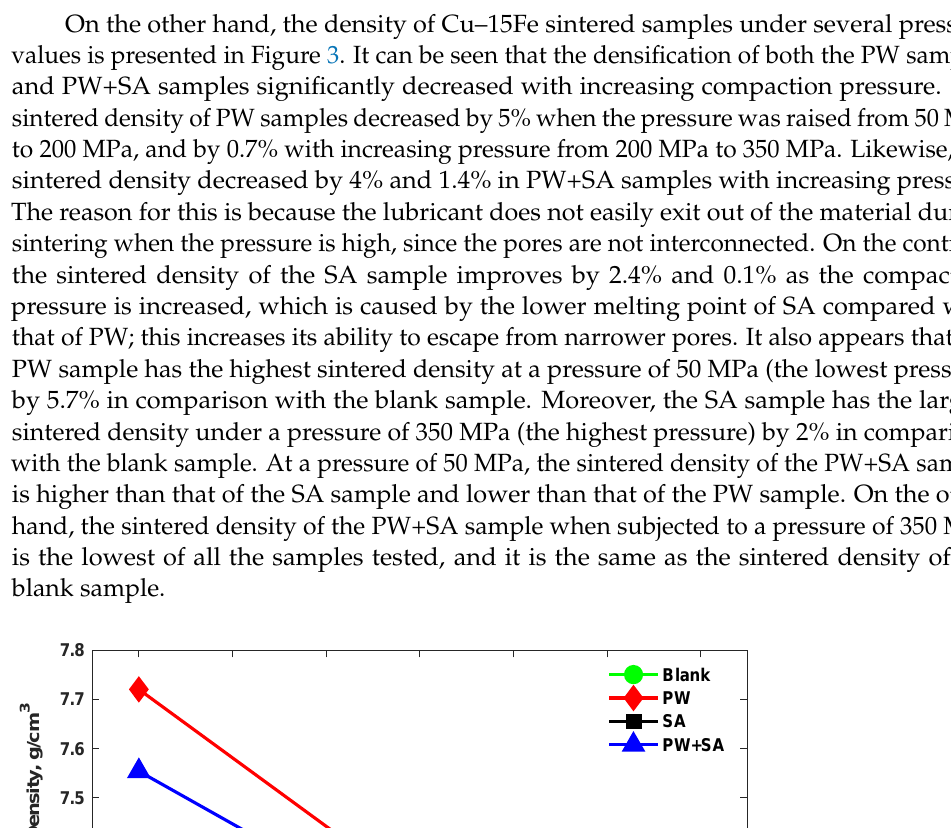
Figure 2. The effects of various compaction pressure levels of the green density of Cu–15Fe green samples with and without different lubrication types.